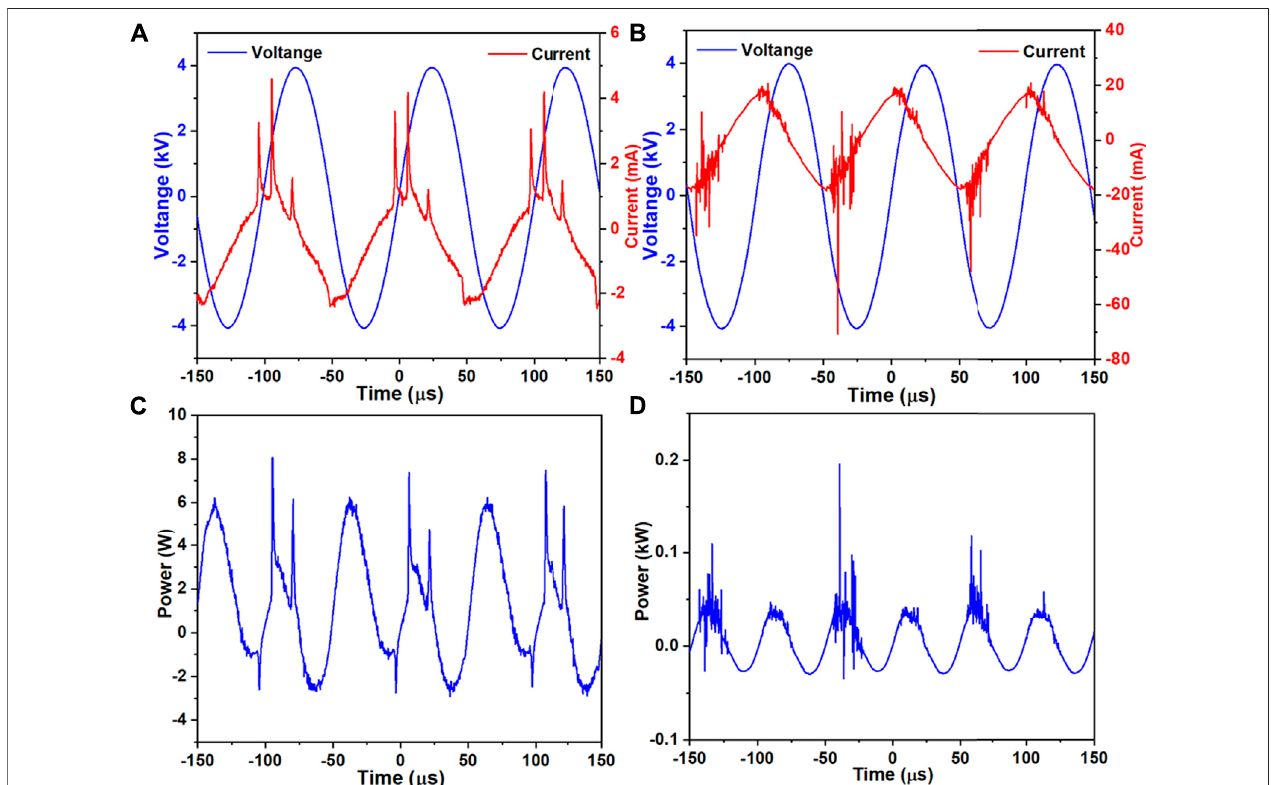
FIGURE 2 | Waveforms of voltage and current (A, B) and power (C, D) for the jet (A, C) and surface (B, D) devices.